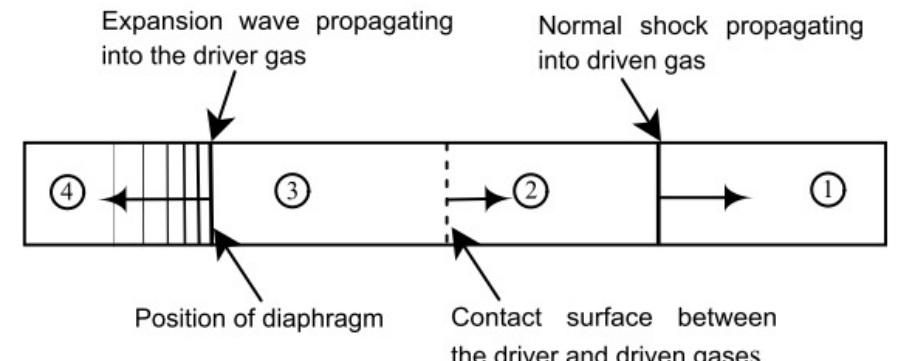
Figure 1. Shock tube flow after the diaphragm is